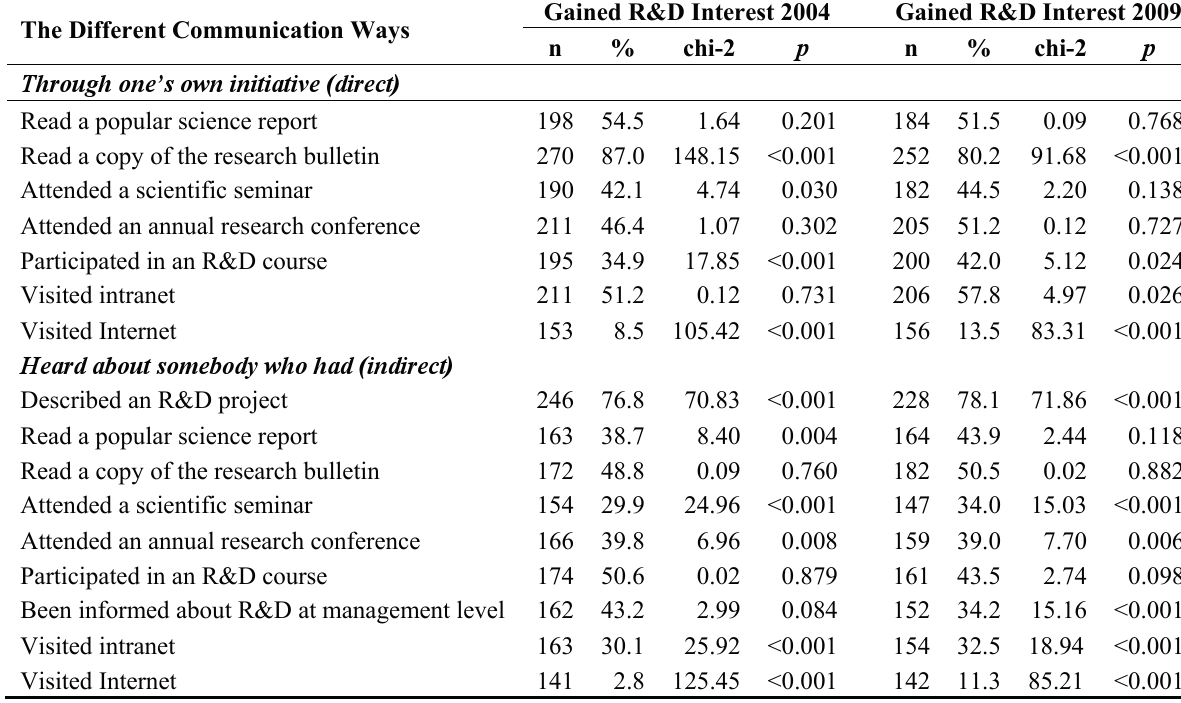
Figure 2. Impact of the direct (D) and indirect communication (ID) communication channels on the creation of interest in R&D among primary care staff measured on two occasions.